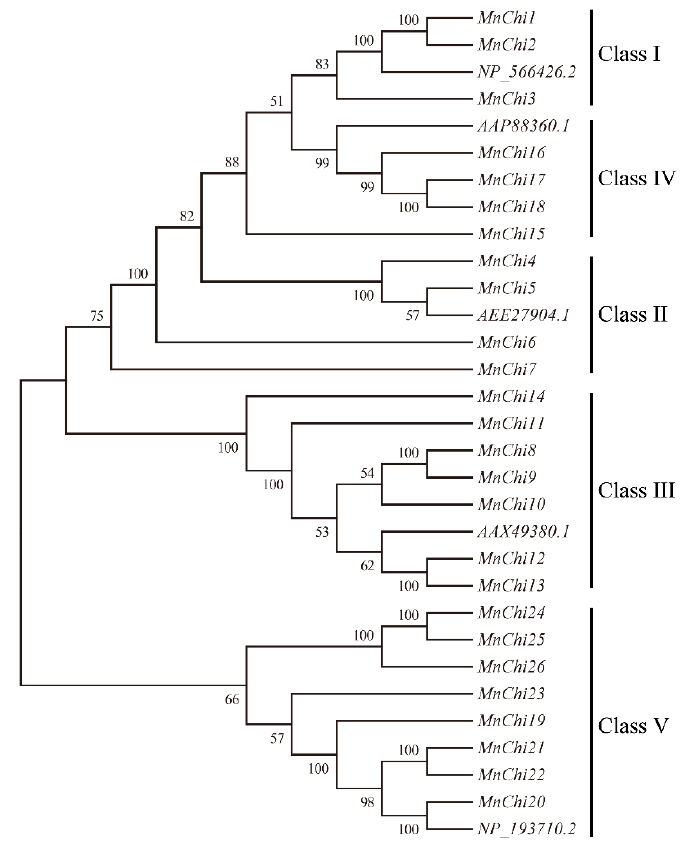
Figure 1. Phylogenetic tree of the chitinase genes from M. notabilis and Arabidopsis . The neighbor- joining (NJ) was used to construct a phylogenetic tree. The tree was generated by chitinase amino acid sequences using MEGA6. The numbers represent confidence percentages.